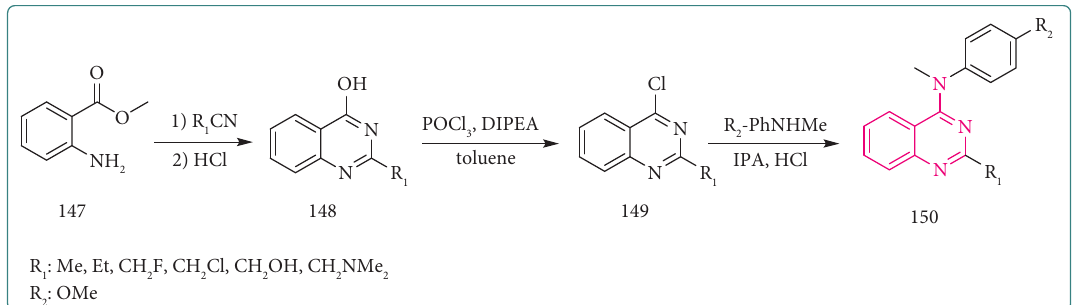
Scheme 27: Synthesis of 4-aminoquinazoline derivatives using 2-aminobenzoic acid methyl ester in the presence of POCl